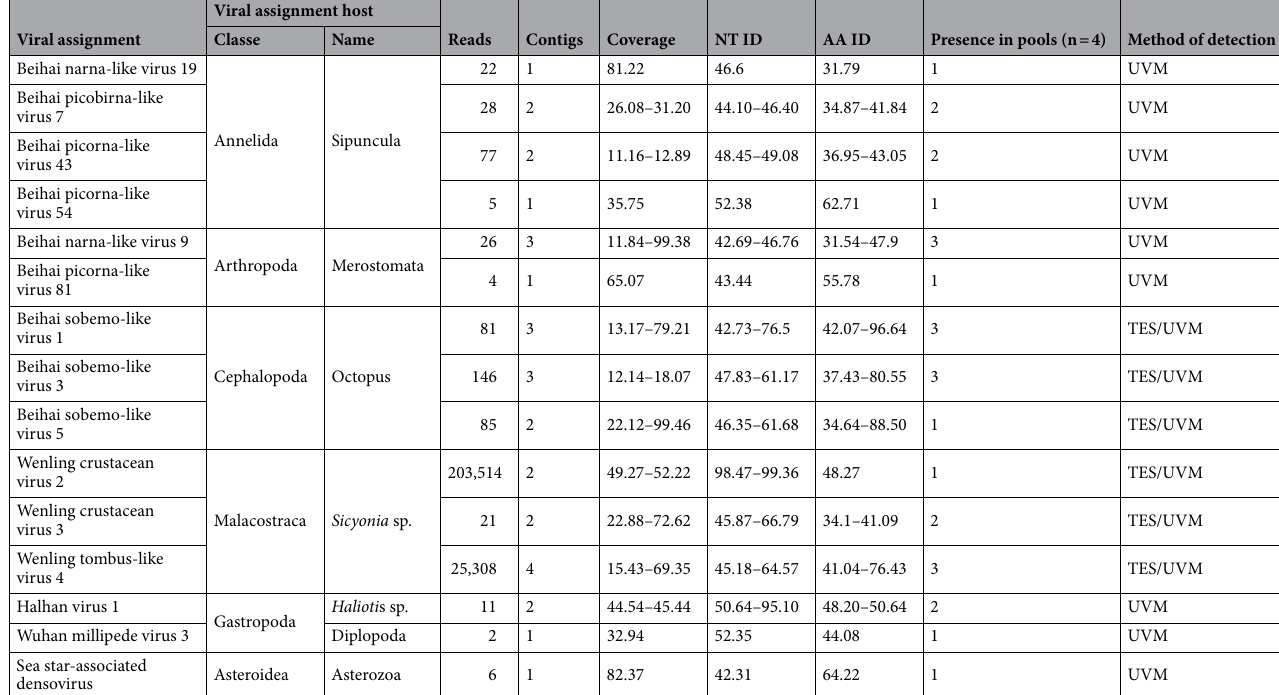
Table 2. Invertebrate viral assignations obtained from fecal samples sequencing from male A. gazella . Colours represent the presence of each assignation in the processed pools. Ranges of Coverage, NT ID and AA ID are represented in